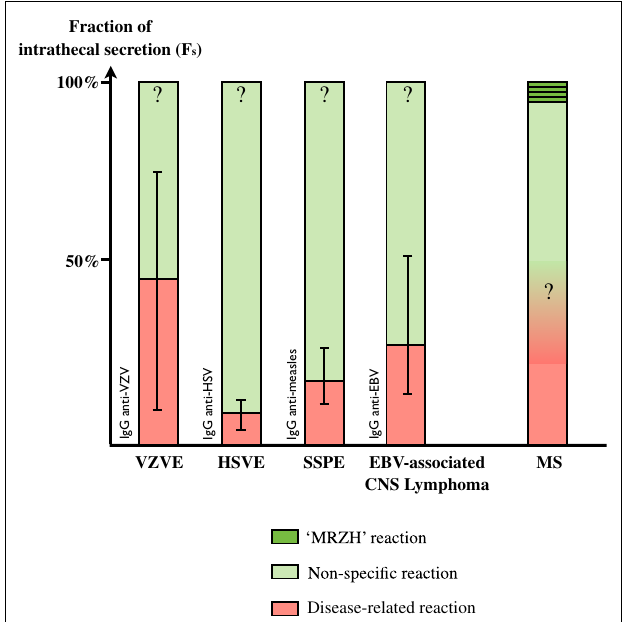
FIGURE 3 | Fraction of intrathecal Ig secretion in various disorders . Disease-related Ig secretion is minor even in infectious disorders (See Ref. in text). Intrathecal synthesis is mostly dominated by non-specific synthesis, including an MRZH pattern, which represents a minor proportion. Disease-related secretion in MS and MRZH patterns in infections are as yet unknown.